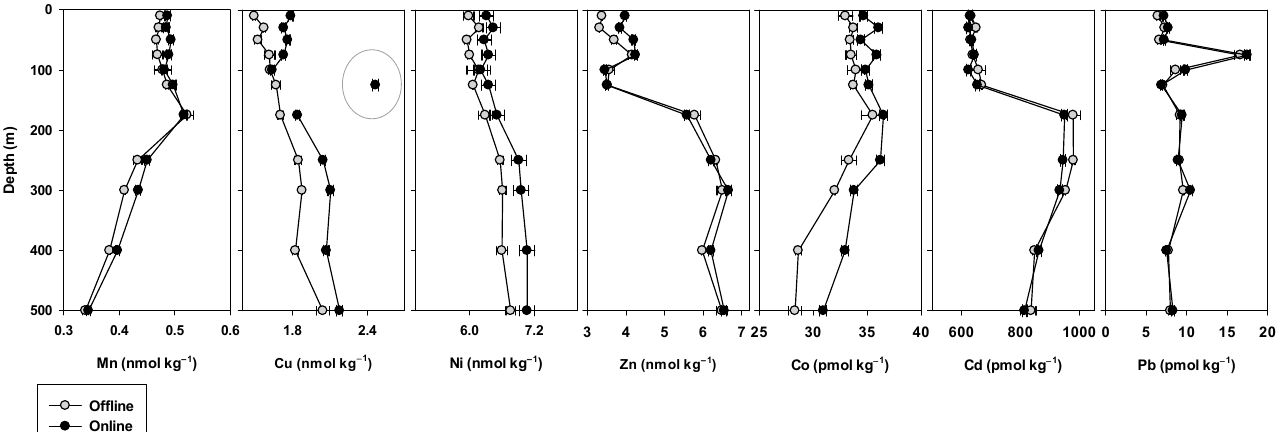
Figure 1. Offline vs. Online vertical profiles of trace metals. For some data points, error bars are smaller than symbol size and not visible. The data point isolated within a circle for Cu represents potential contamination during sample handling.